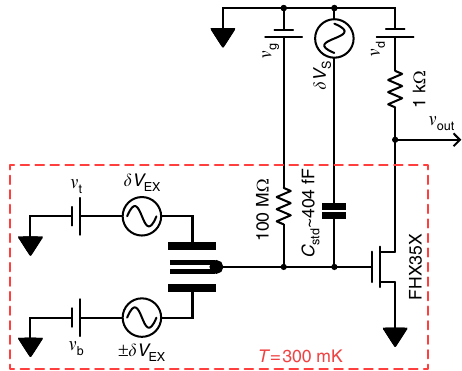
Fig. 5 Electrical schematic of the capacitance measurement. DC voltages v t , v b and v g together control n 0 and p 0 , with fi xed v g ≈ − 300 mV such that the transistor ampli fi er is at its optimal working point. For C S measurements, an AC excitation δ V EX is applied to both top and bottom gate. δ V S is then chosen to balance the bridge for a single set of DC voltages, i.e., such that δ v = 0, in which case C = δ V δ V out S / C std S / EX . n 0 and p 0 are then swept and δ v out monitored, from which C S ( n 0 , p 0 ) is extracted. For C A , the measurement proceeds identically but with opposite phase signals applied to the two